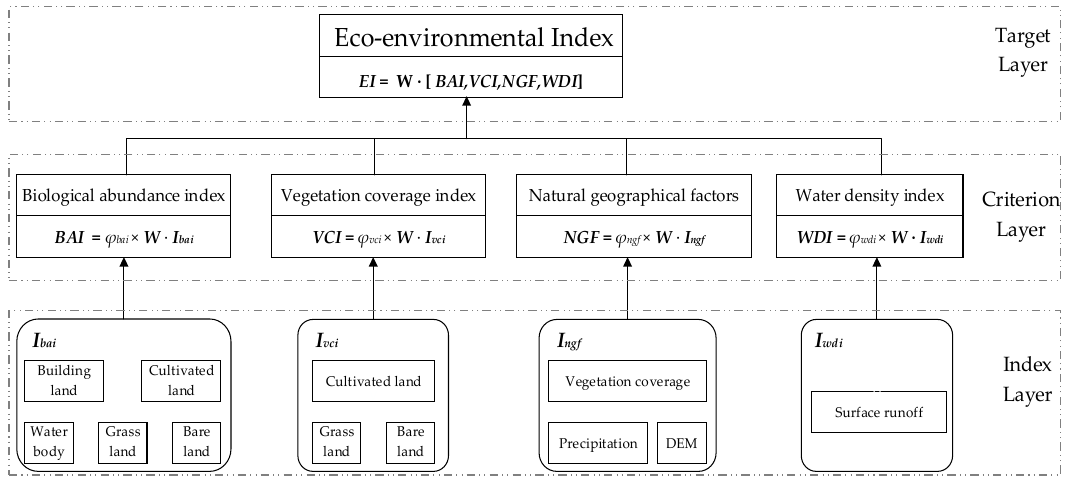
Figure 3. The Hierarchy model construction.